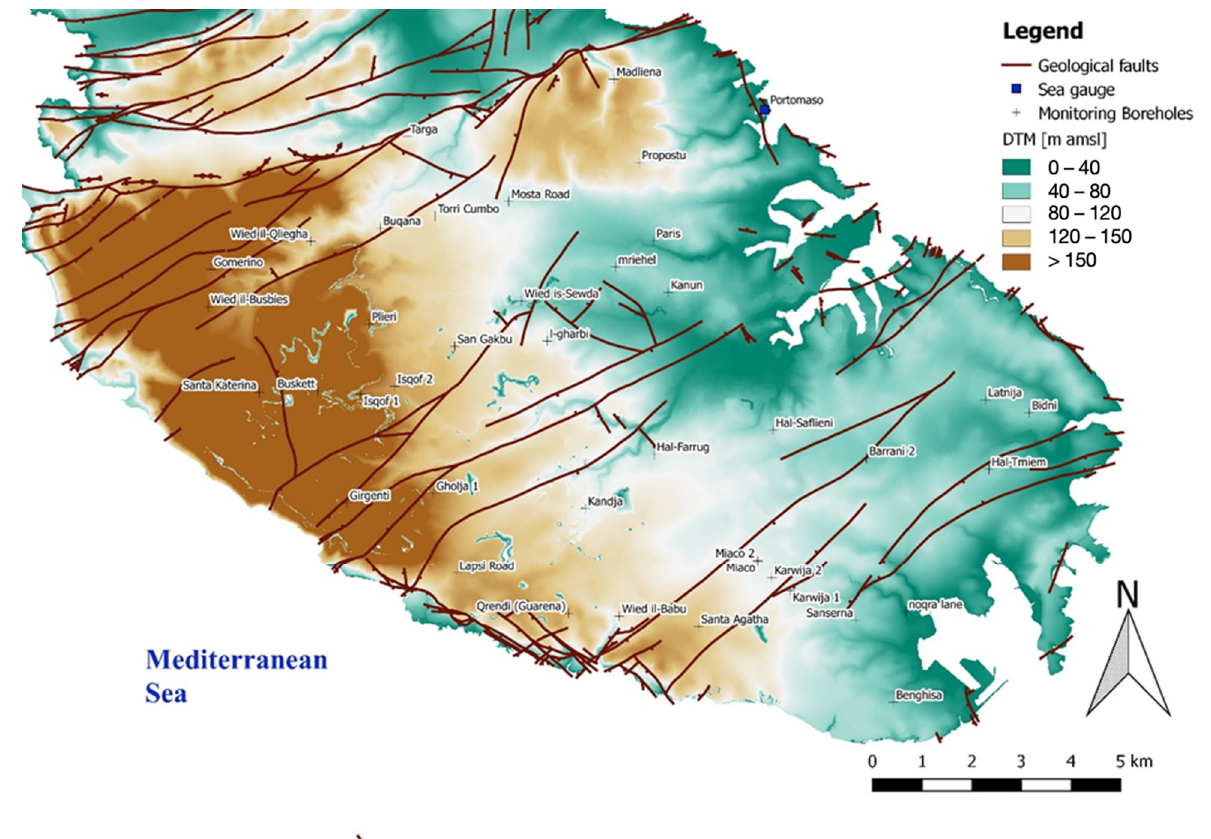
Figure 4. Digital Terrain Model and geological fault systems showing monitoring boreholes’ locations in the MSLA of Malta. Table 1. Average values of analysed monitoring boreholes during the period of analysis (from 1st May until 31st July